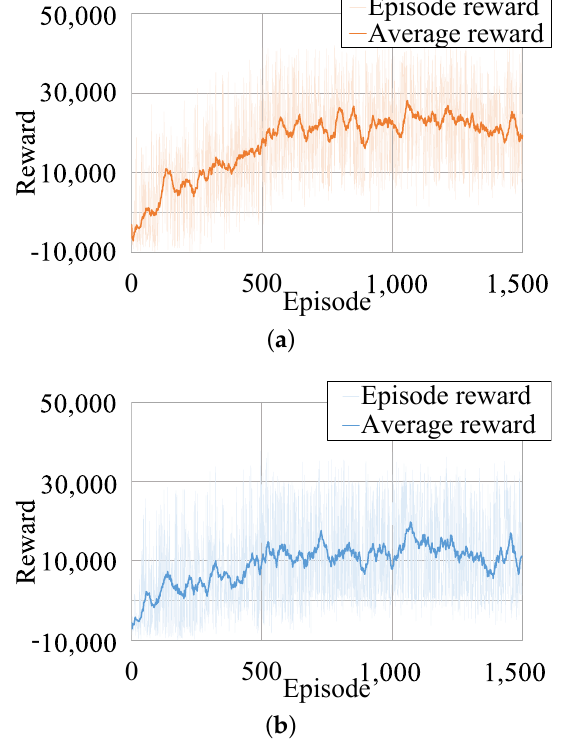
Figure 8. The training rewards of two RL schemes. ( a ) The training rewards generated by DDPG-ID. ( b ) The training rewards generated by DDPG.